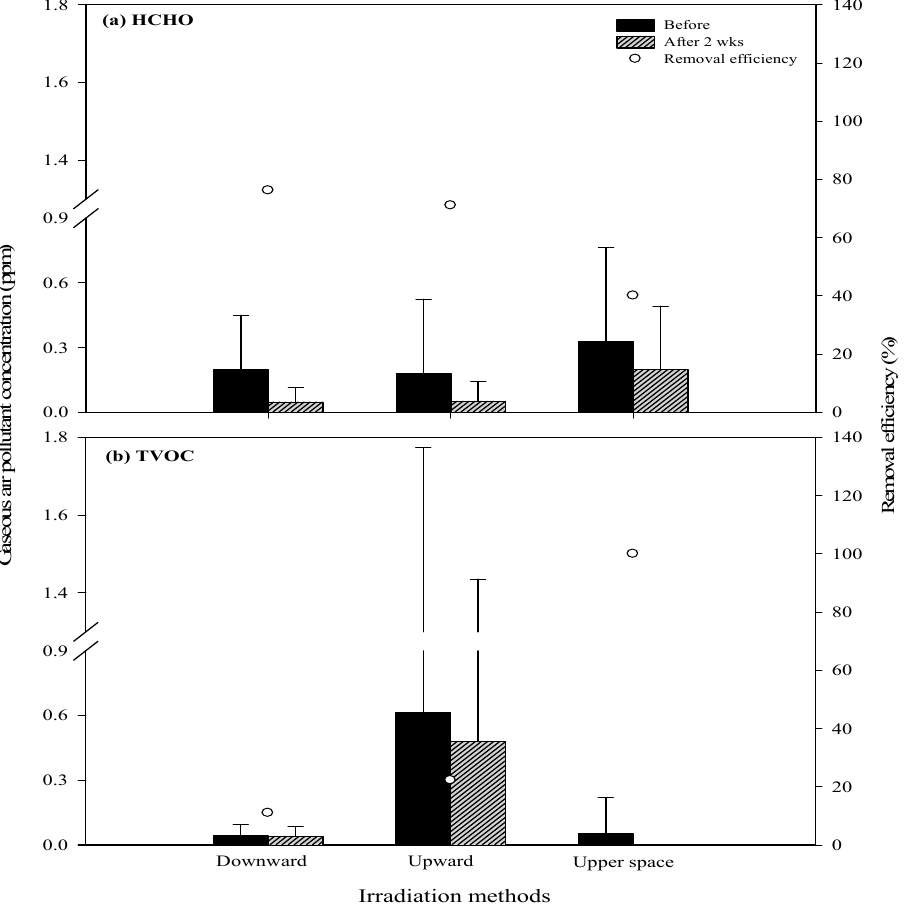
Figure 6. Efficiency of chemical air pollutants: ( a ) HCHO and ( b ) TVOC removal by varying UVGI irradiation methods.